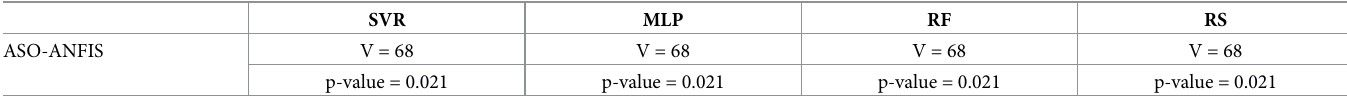
Table 6. Significance test between the ASO-ANFIS and the benchmarked classifiers.